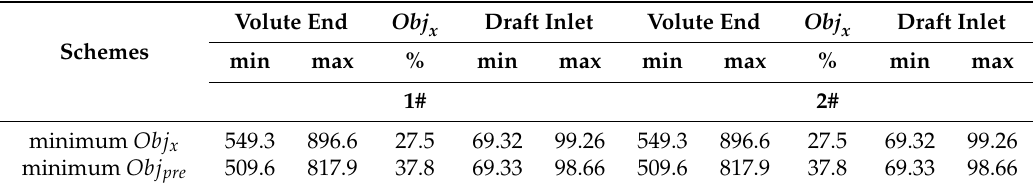
Table 7. The index values of the minimum Obj x and Obj pre schemes of scenario 3 (II).